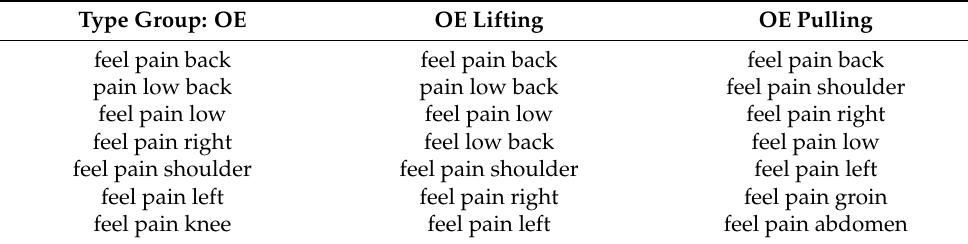
Table 4. Results of trigram analysis on OE accident types.